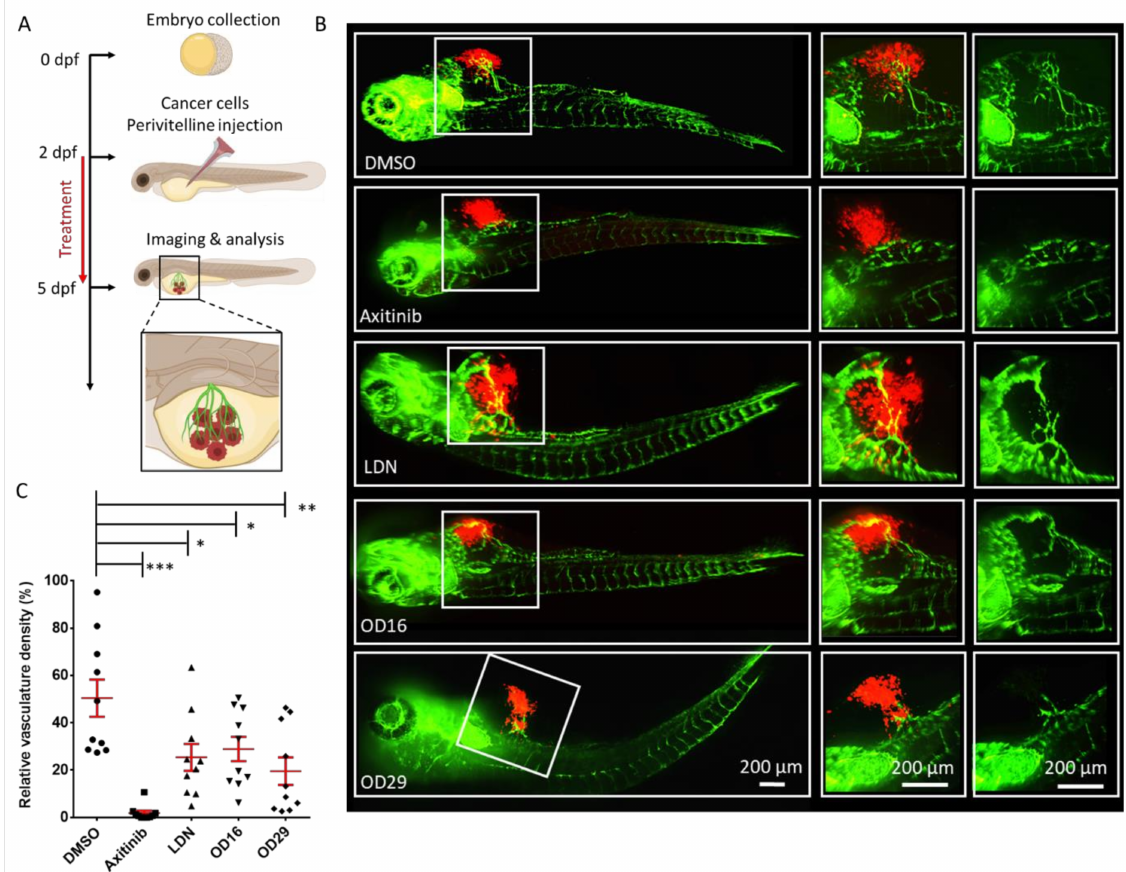
Figure 7. OD16 and OD29 inhibit vessel invasion in a breast cancer xenograft model in zebrafish. ( A ) Schematic repre- sentation of the experimental procedure. Two dpf zebrafish embryos were injected with mCherry (red) labeled human MDA-MB-231 breast cancer cells in the perivitelline space. The injected zebrafish embryos were challenged with testing compounds in egg water for 3 days, and the newly formed vessels within the perivitelline were analyzed. ( B ) Representative images of the eGFP expressing blood vessels (green) and mCherry MDA-MB-231 cells (red) after treatment of the zebrafish embryos with vehicle control (DMSO), Axitinib, LDN-193189, OD16, or OD29 (0.5 µ M) for 3 days. The medium (vessels and tumor cells are visualized) and right panels (only vessels are visualized) represent high magnification views of the area, indicated by white rectangles in the overviews (left panel) images. Scale bars represent 200 µ m. ( C ) Quantification of the relative vasculature density induced by the injected MDA-MB-231 cells within the perivitelline space of the zebrafishes in each group. * p < 0.05, ** p < 0.005, *** p <